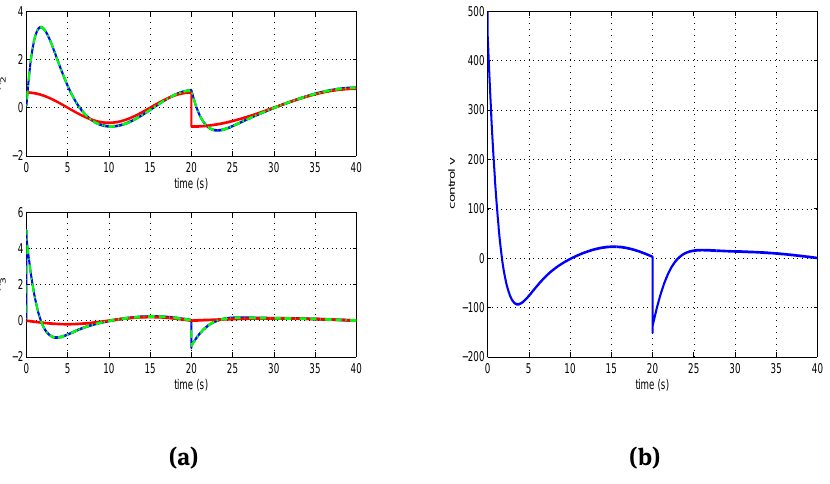
Fig. 6: Setpoint 4: (a) Convergence of the state variables of the SRM x 2 = ω , x 3 = ˙ ω (blue line: real value, green line: estimate value) by the H-infinity filter) to the associated reference values (red line). (b) Control input v applied to the control system of the